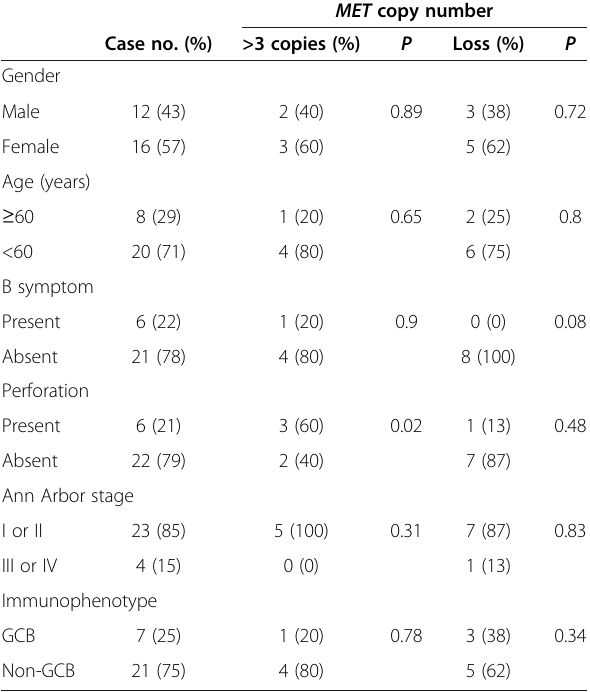
Table 1 Correlation between MET copy number and